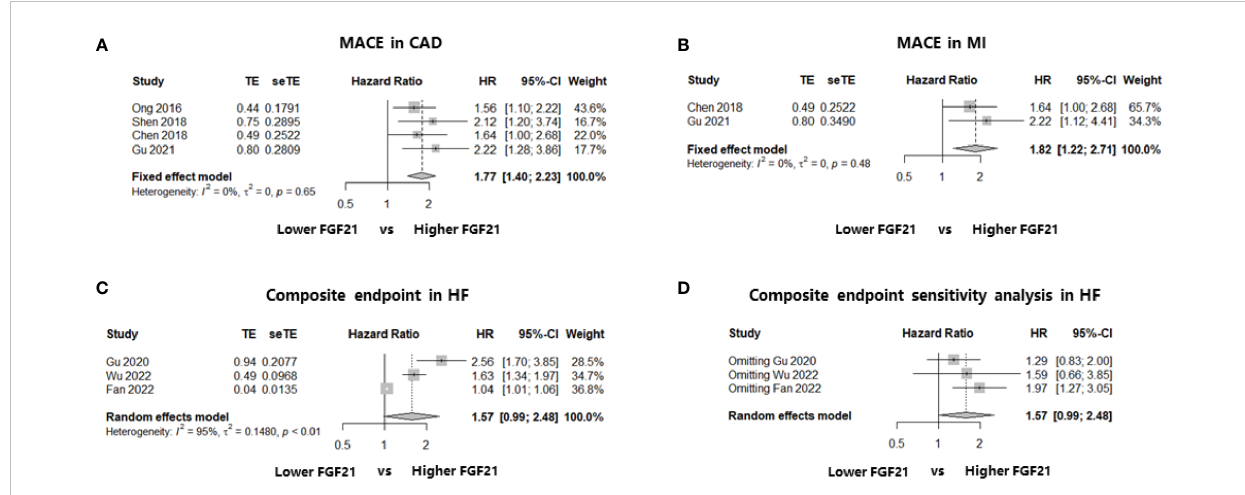
FIGURE 2 Forest plots of the association of FGF21 with endpoints in patients with CAD or HF. Figure 2 shows the synthesized effect sizes of FGF21 on predicting endpoints among either CAD or HF patients. The endpoint for CAD and HF was MACE and a composite of all-cause death or HF readmission, respectively. (A) FGF21 and MACE in CAD; (B) FGF21 and MACE in MI; (C) FGF21 and a composite of all-cause death or HF readmission in HF; (D) sensitivity analysis of endpoint in HF. FGF21, fi broblast growth factor 21; CAD, coronary artery disease; HF, heart failure; MACE, major adverse cardiovascular event; MI, myocardial